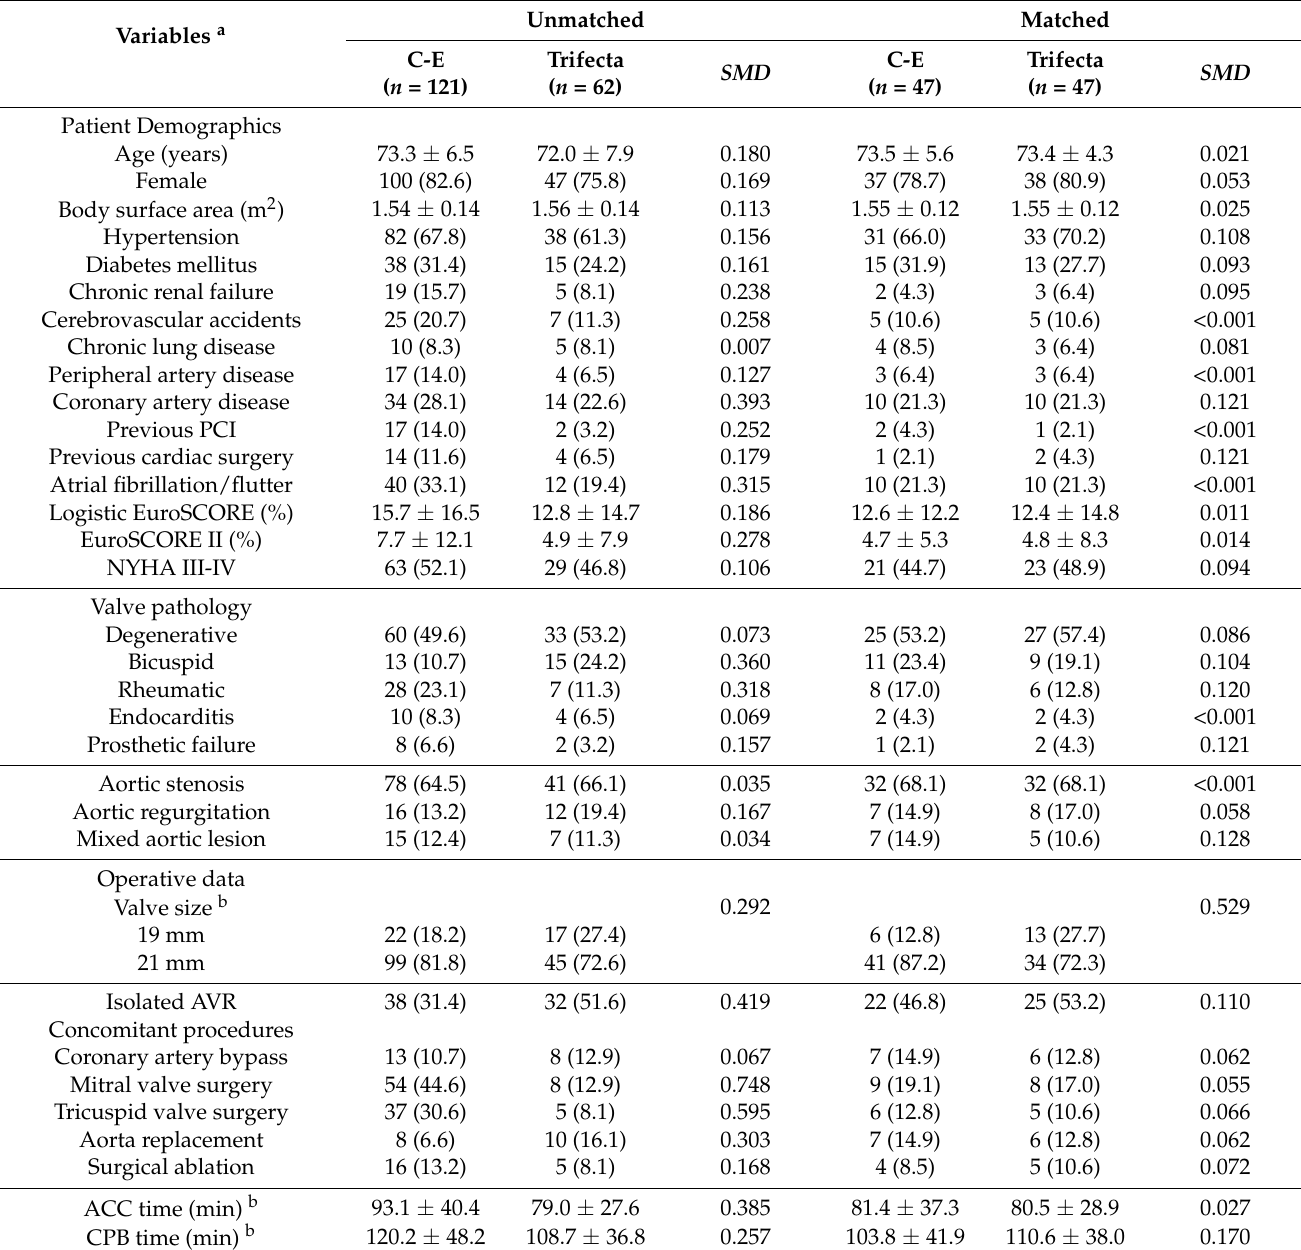
Table 1. Baseline characteristics and operative data before and after propensity score matching